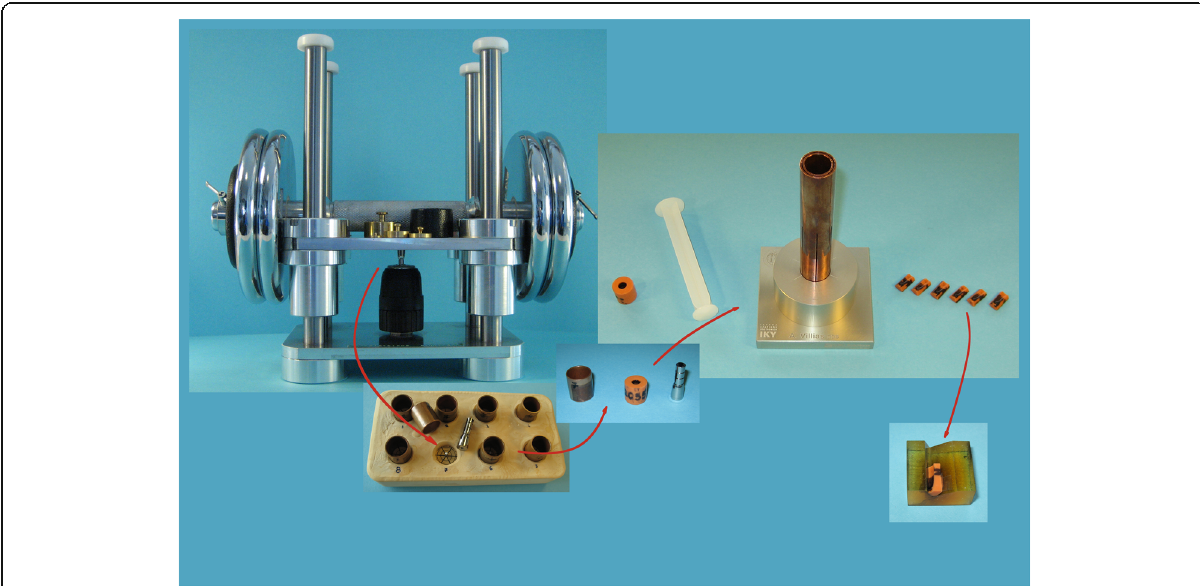
Fig. 2 The original apparatus implemented in the study. From left to right following the arrows: A cemented experimental crown held at the Axial Loading Device (ALD), the slot at the Replica Production Device (RPD) where the cemented crown would be replicated, the acquired negative replica from within the specialized copper tray with the corresponding cemented experimental crown on the right, the negative replica inserted with a plastic plunger in the inner tube of the Sample Intersection Device (SID), and the six negative replica slices on the right, which were the observation units. Finally, each slice was placed on the Sample Observation Base (SOB) for examination under a